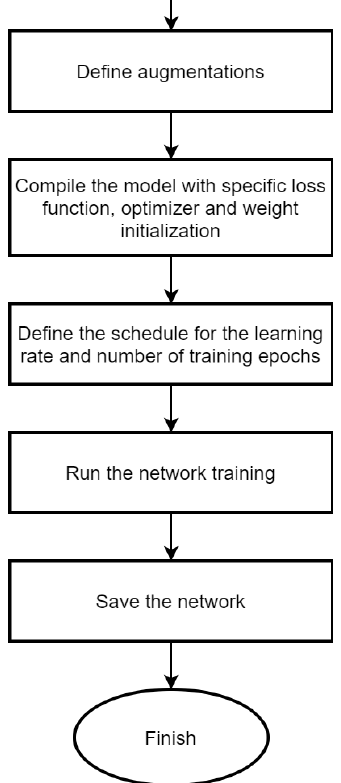
Figure 3. Basic process structure of the radar data classification model